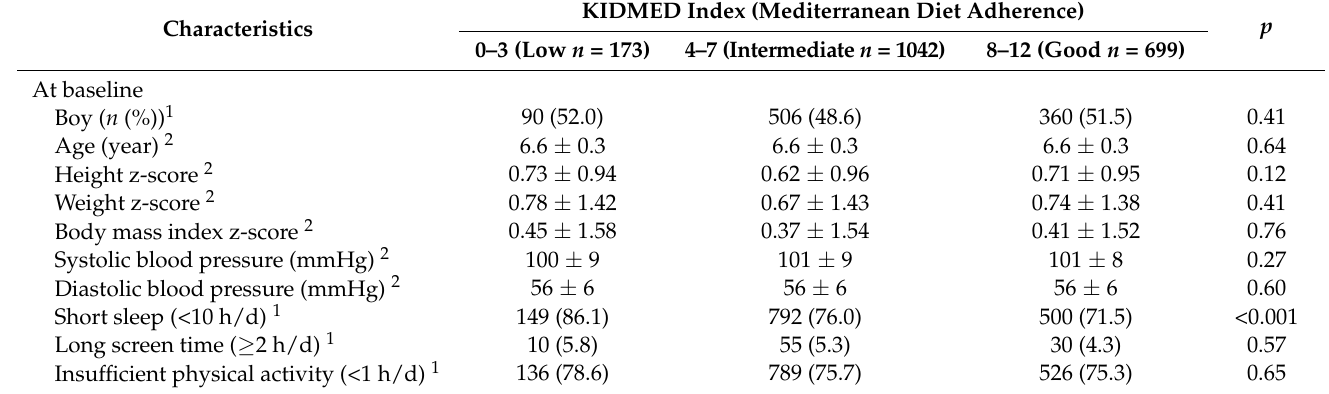
Table 1. Participants’ characteristics categorized by KIDMED index of children aged 6–9 in Beijing, China (N =